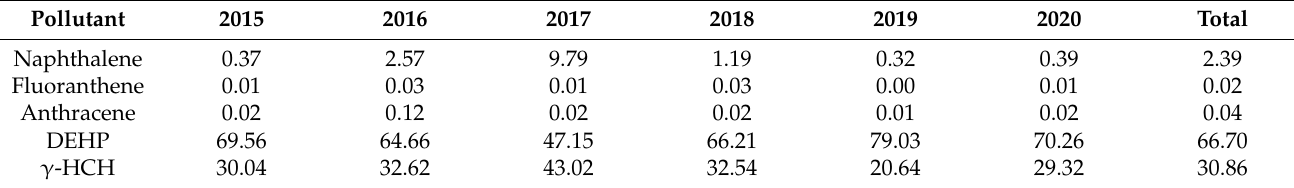
Table 6. The contribution of organic pollutants to the total impact scores.